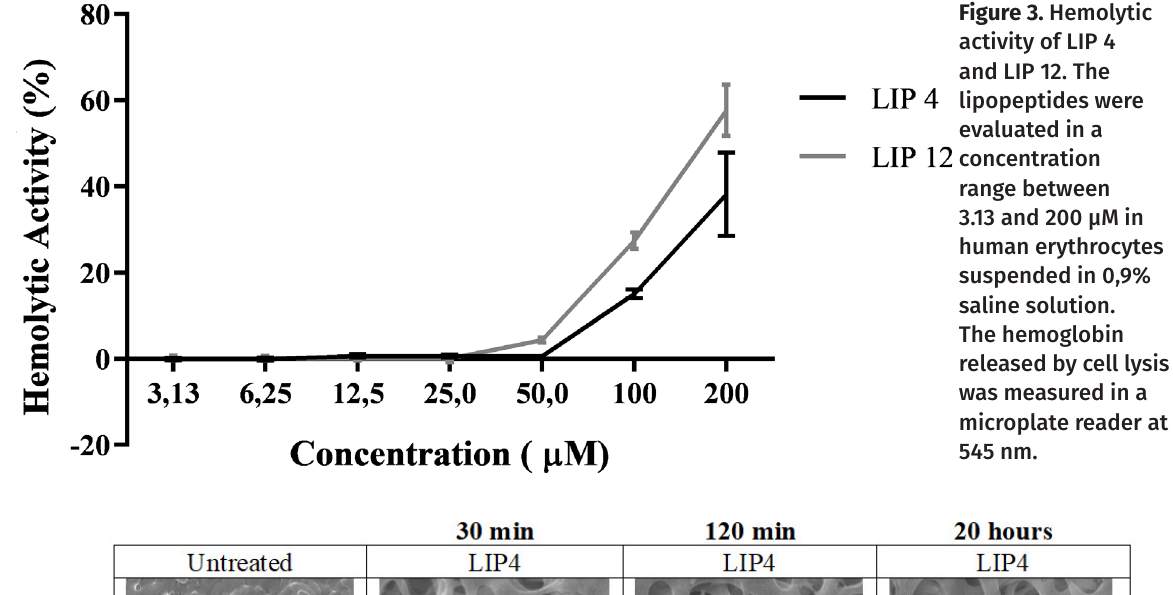
Figure 3. Hemolytic